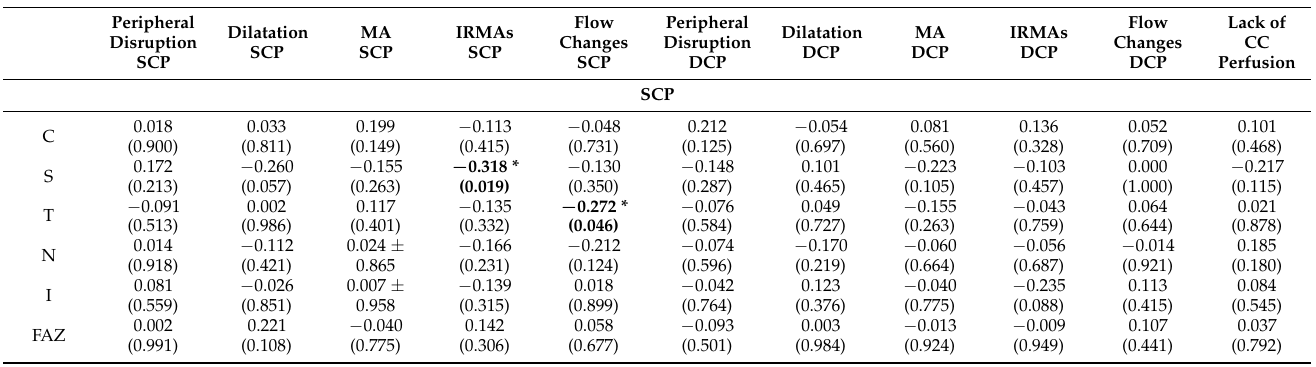
Table 5. Correlation coefficient and p -value (in brackets) of the anatomical alterations in type 2 diabetes mellitus (DM2) in the SCP, DCP and CC in the 5 sectors and in the FAZ. The values that reached statistical significance (* p < 0.05 and ** p < 0.01) are shown in bold. Abbreviations: SCP, superficial capillary plexus; DCP, deep capillary plexus; CC, choriocapillaris; MA, microaneurysms; IRMAs, intraretinal microvascular abnormalities; C, Central; S, Superior; T, Temporal; N, Nasal; I, Inferior; FAZ, foveal avascular